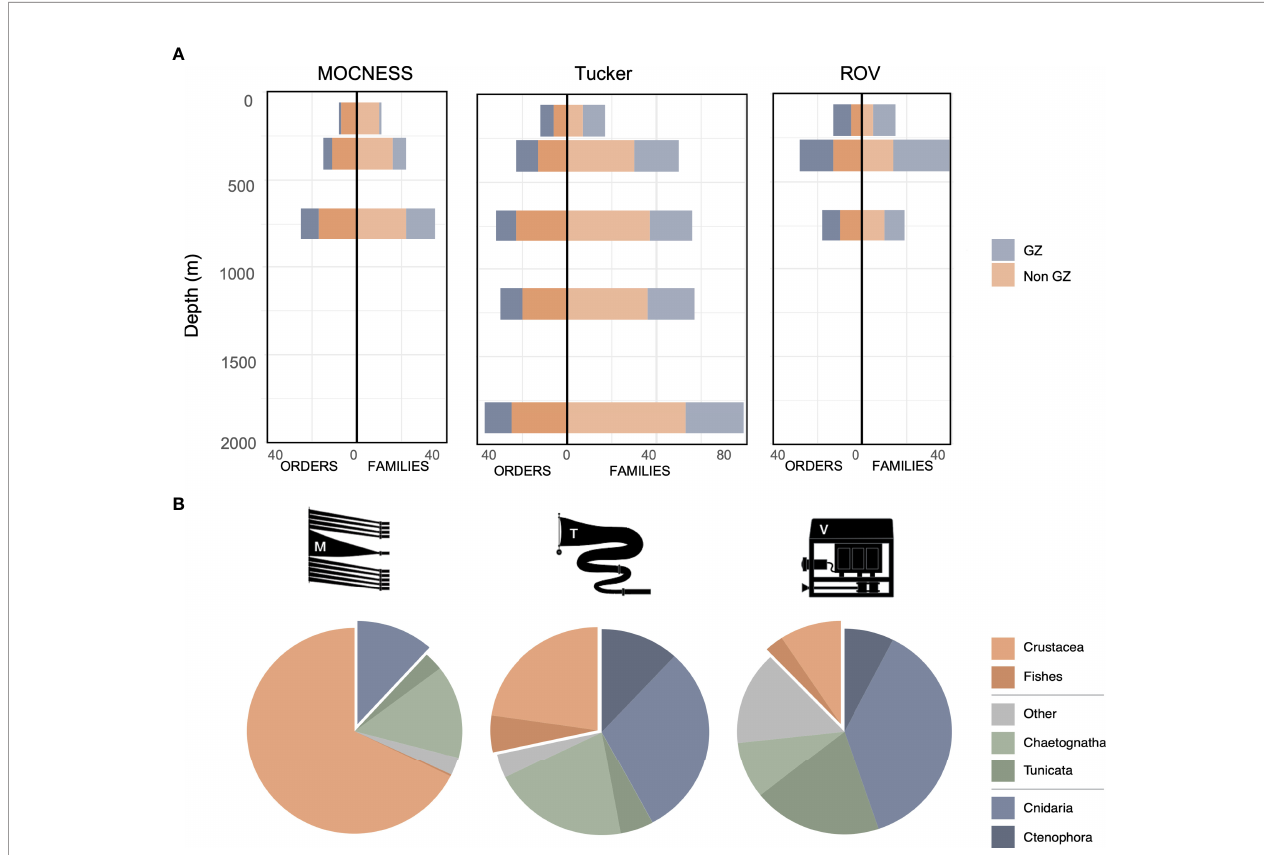
FIGURE 2 | (A) Number of taxonomic orders and families and (B) mean relative abundances (%) of broad taxonomic groups of pelagic animals identi fi ed in MOCNESS, Tucker trawl, and ROV video samples in Monterey Bay. Taxa in (A) were grouped into gelatinous zooplankton (GZ; cnidarians, ctenophores, tunicates) or non-gelatinous taxa (crustaceans, fi shes, mollusks, worms). Pie slices in (B) for gelatinous animals (blue) and crustaceans (orange) are isolated to highlight the primary differences between sampling